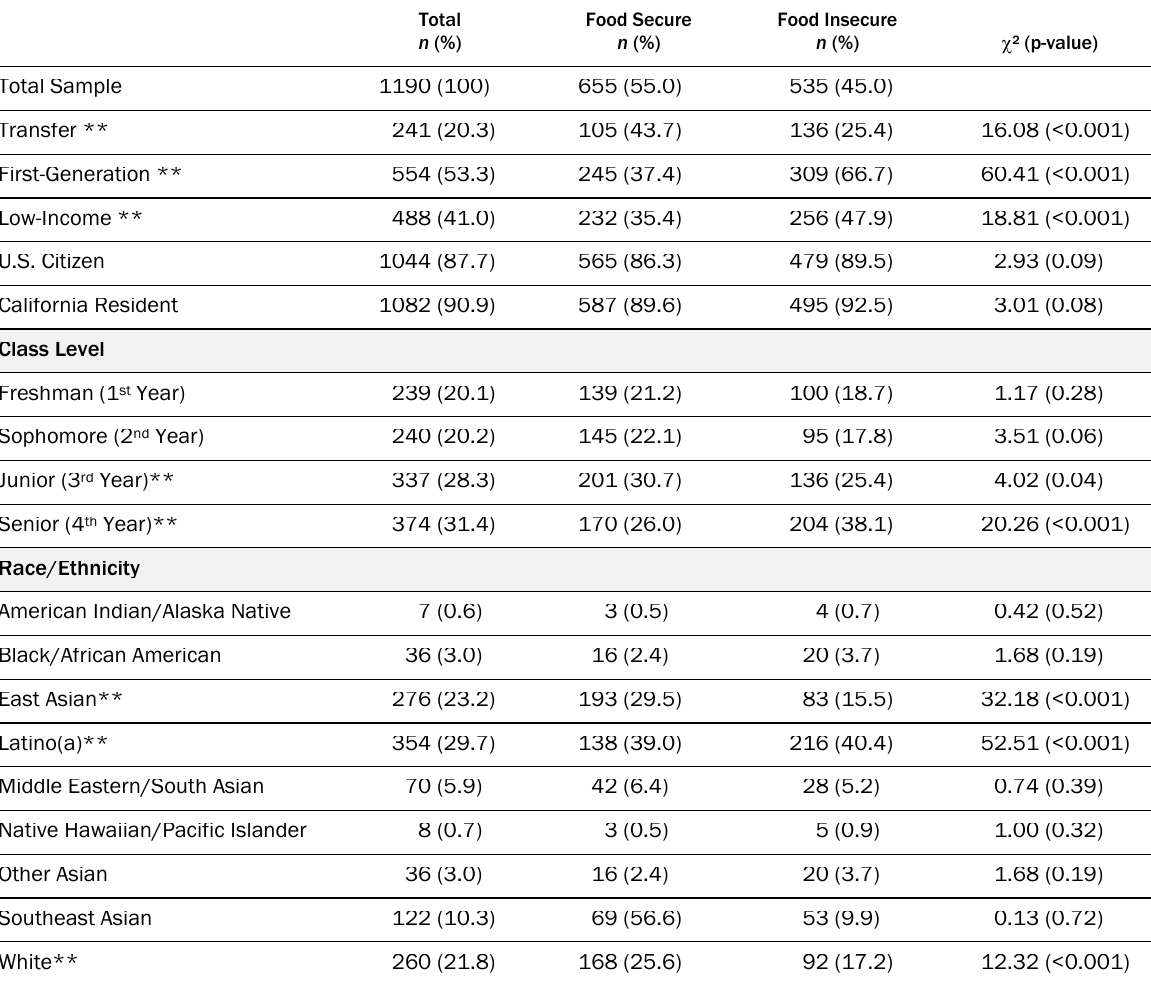
Table 1. Descriptive Characteristics of Sample and Chi-Square Test of Food Security